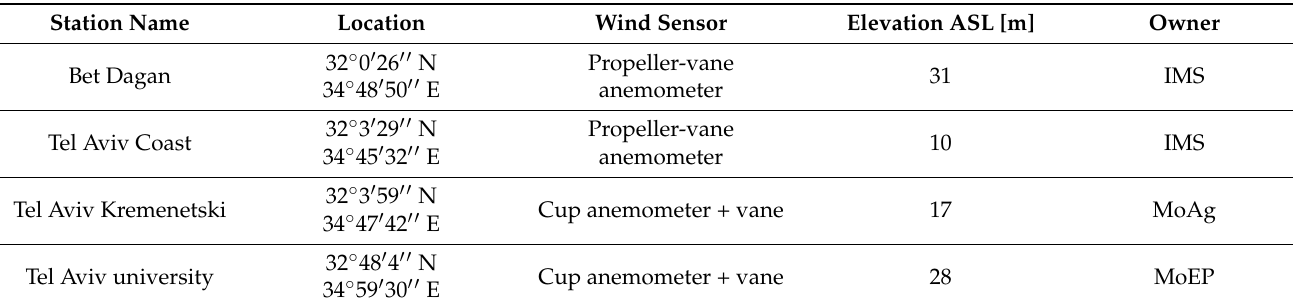
Table 1. The stations analysed in this study. Stations owners and abbreviations: IMS (Israel Meteorological Service), MoAg (Israel Ministry of Agriculture and Rural Development), MoEP (Israel Ministry of Environemtnal Protection). These stations are a part of ongoing monitoring networks available online: IMS (https://ims.data.gov.il/ims/7 (accessed on 8 February 2021)), MoAg and EPA (https://meteo.co.il/ (accessed on 8 February